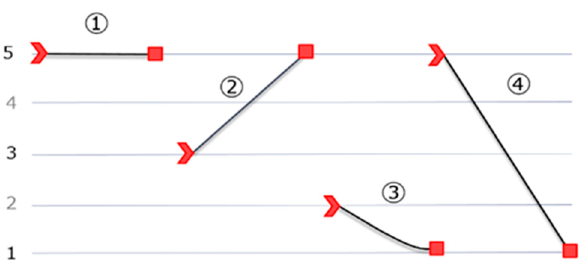
Figure 1. Four tones in Mandarin Chinese using five-level tone marks (the numbers on the left side show the relative pitch: 1. Bottom, 2. Low, 3. Mid, 4. High, 5. Top).